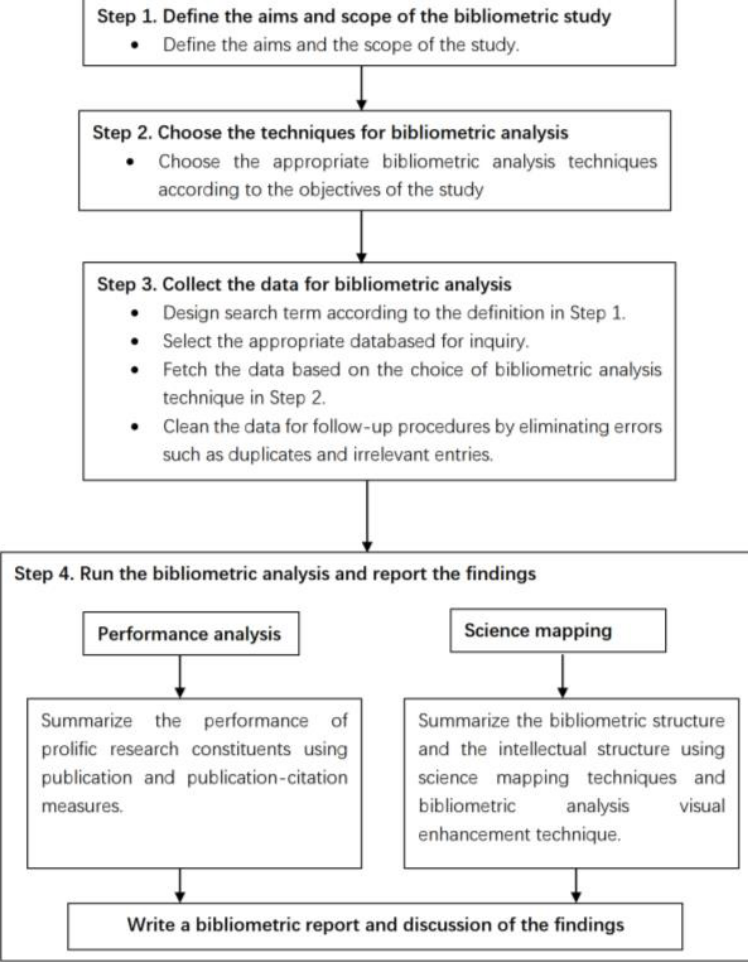
Figure 1. The bibliometric flowchart of this study.